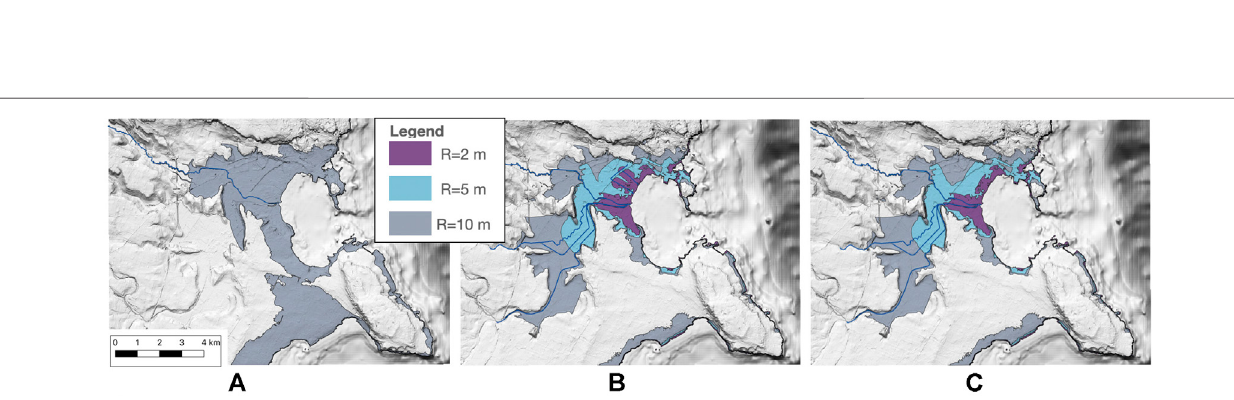
FIGURE 6 | Same as Figure 5 , but for